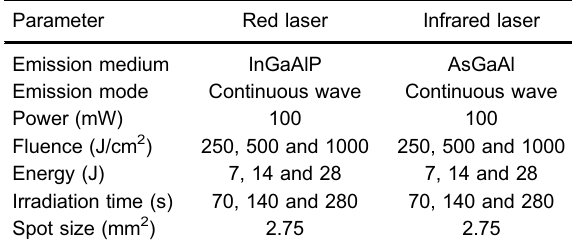
Table 1. Low-intensity laser